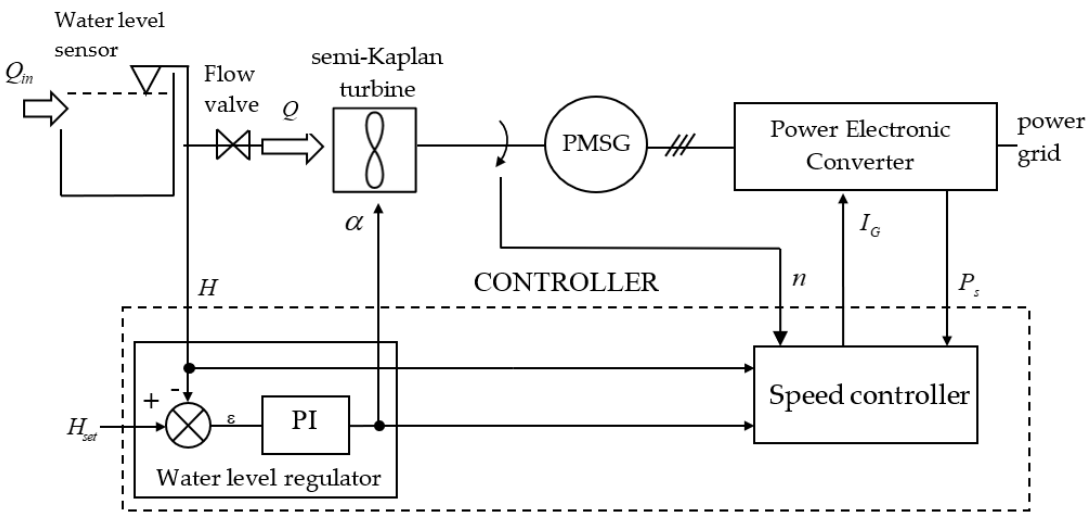
Figure 24. Control algorithm of single hydro-set with semi-Kaplan turbine.